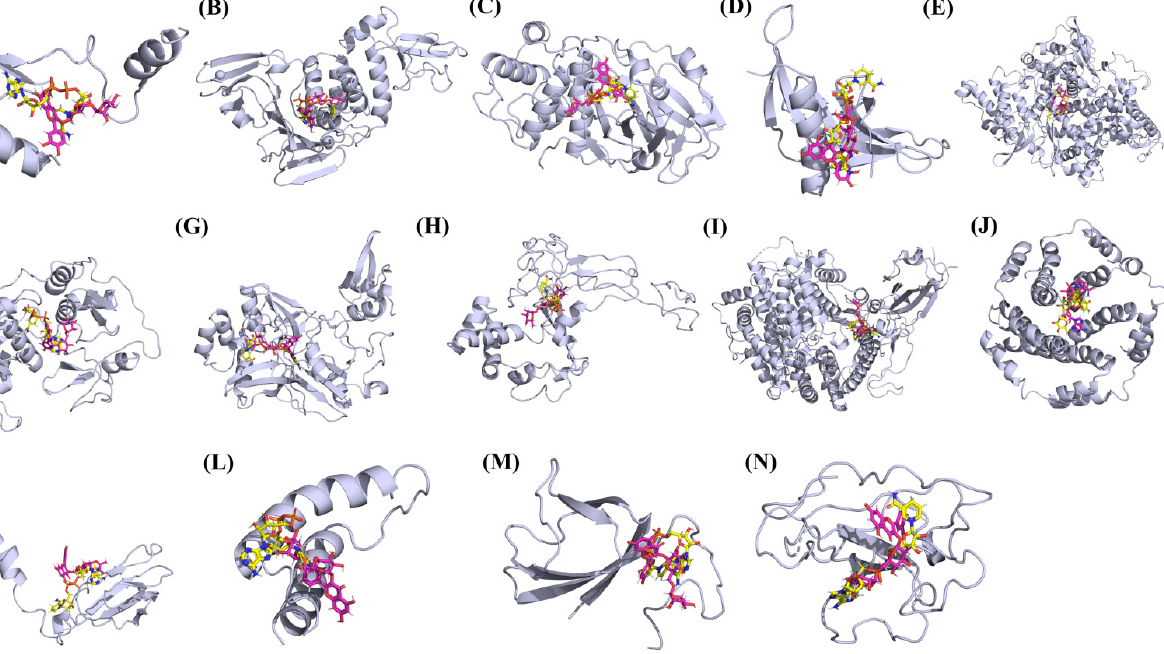
Figure 15. The binding mode of rutin (pink) and NADH (yellow) with the 14 different SARS-CoV-2 proteins. (A) NSP1. (B) NSP3. (C) NSP5. (D) NSP9. (E) NSP12. (F) NSP13. (G) NSP15. (H) ORF3a. (I) proteins. ( A ) NSP1. ( B ) NSP3. ( C ) NSP5. ( D ) NSP9. ( E ) NSP12. ( F ) NSP13. ( G ) NSP15. ( H ) ORF3a. ( I